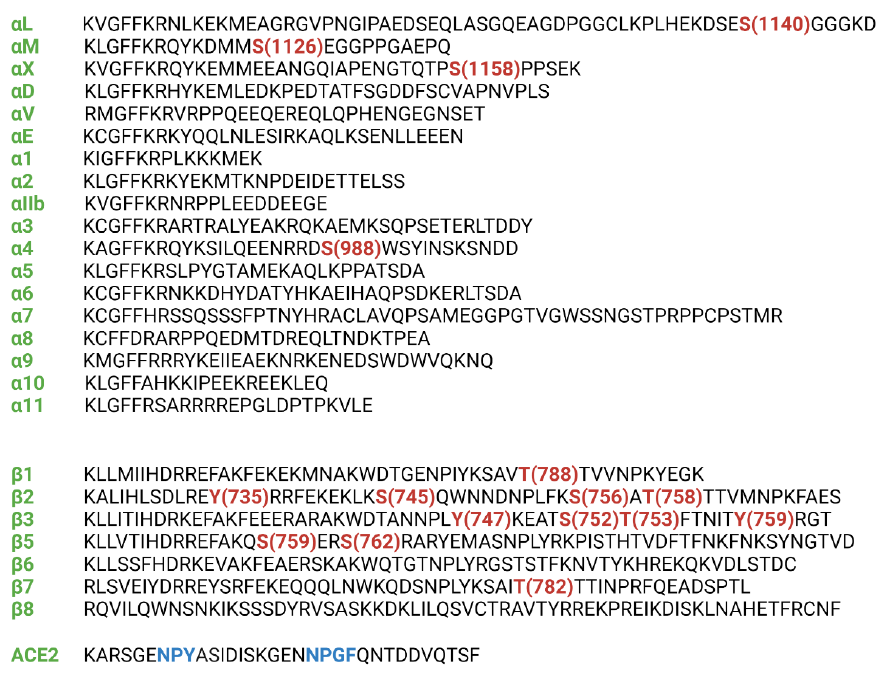
Figure 4. The sequences of the integrin and the major SARS-CoV-2 receptor ACE2 cytoplasmic tails. The known phosphorylation sites are marked in red. In ACE2, the NPXY/F like motifs are marked in blue.